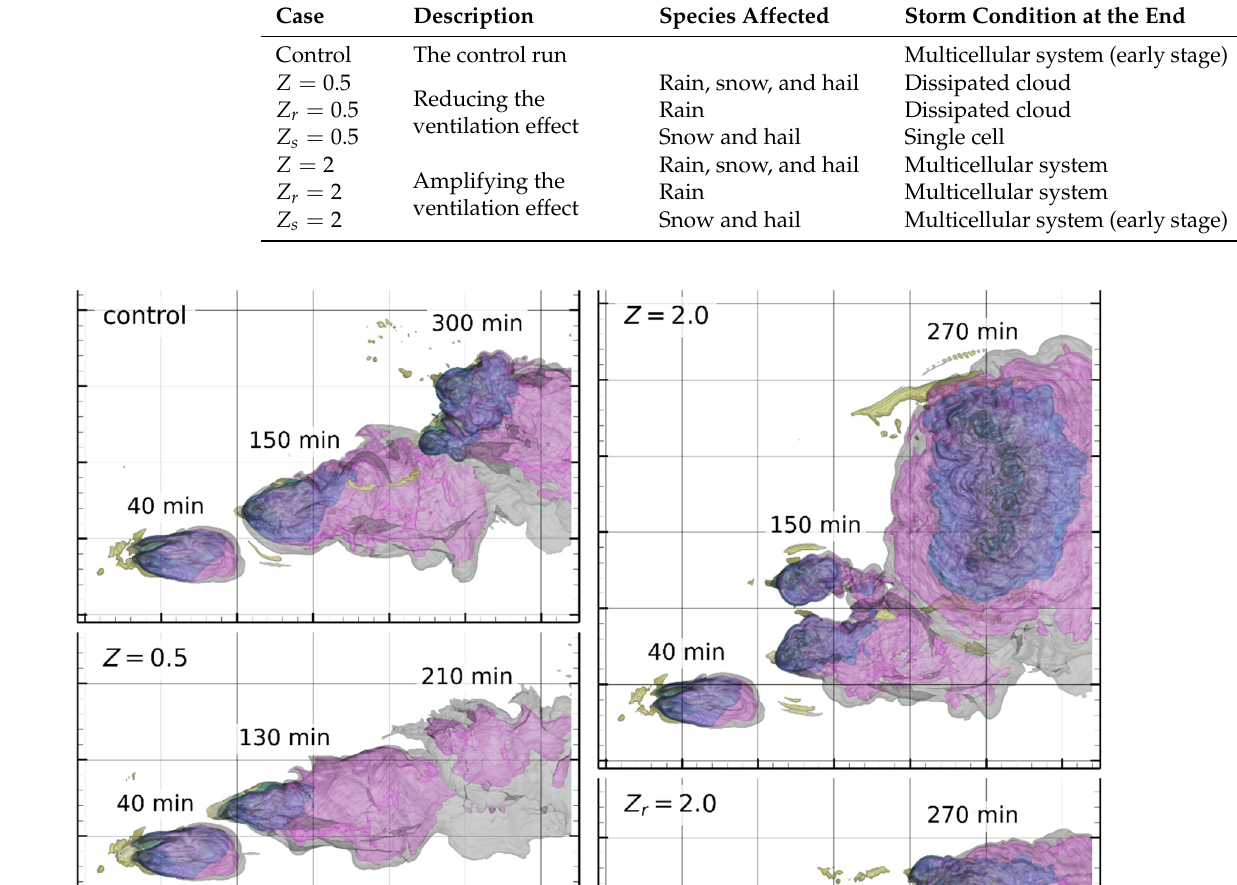
Table 1. The list of the experiments studied in this manuscript.